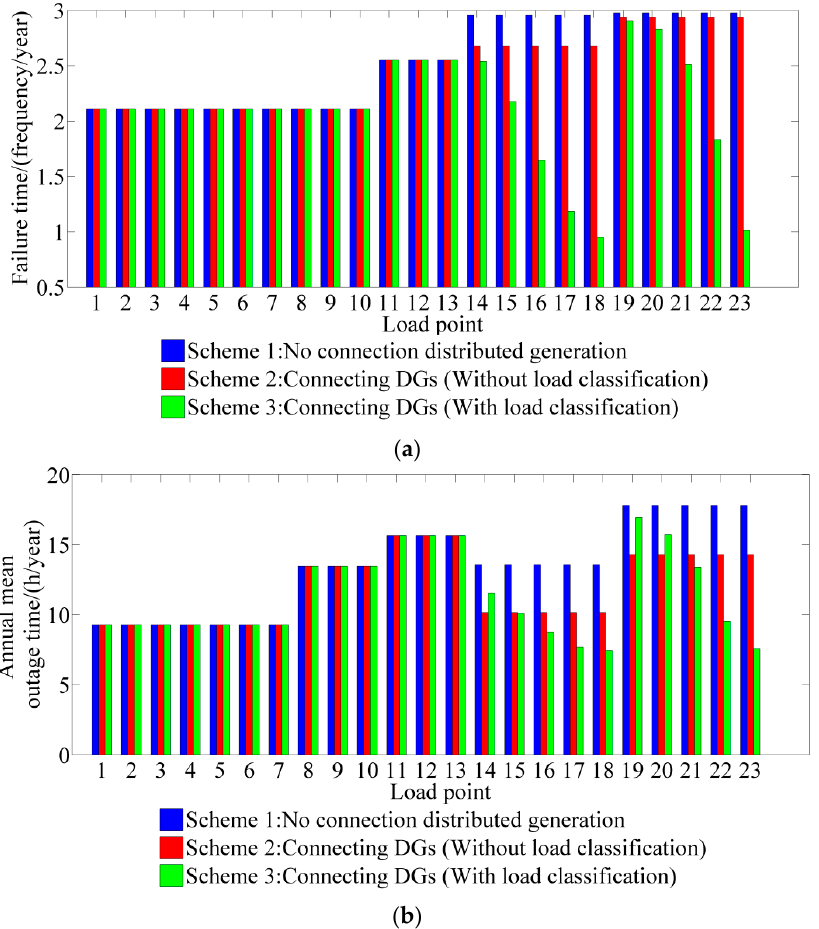
Figure 9. Failure rate and annual average interruption duration of load points. ( a ) Failure rate of load points; ( b ) Annual mean outage time of load points. Table 1. System Reliability Indexes.